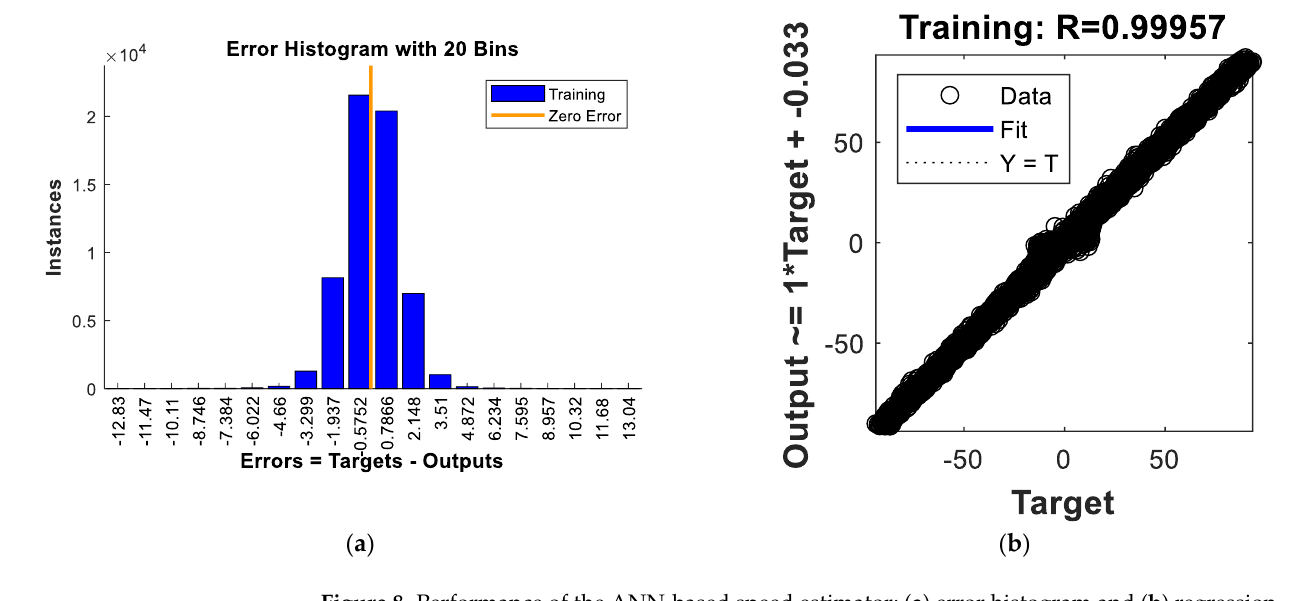
Figure 8. Performance of the ANN-based speed estimator; ( a ) error histogram and ( b ) regression.